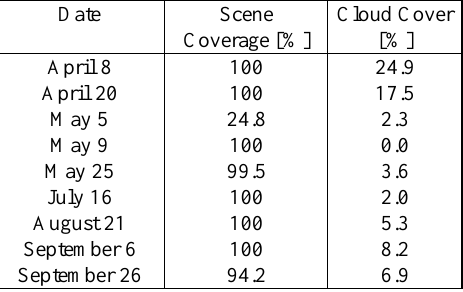
Table 1: Acquisition dates during the vegetation period 2011, percentage of the study area covered by the image, and percentage of pixels within the study area masked due to cloud cover of the RapidEye images used in this